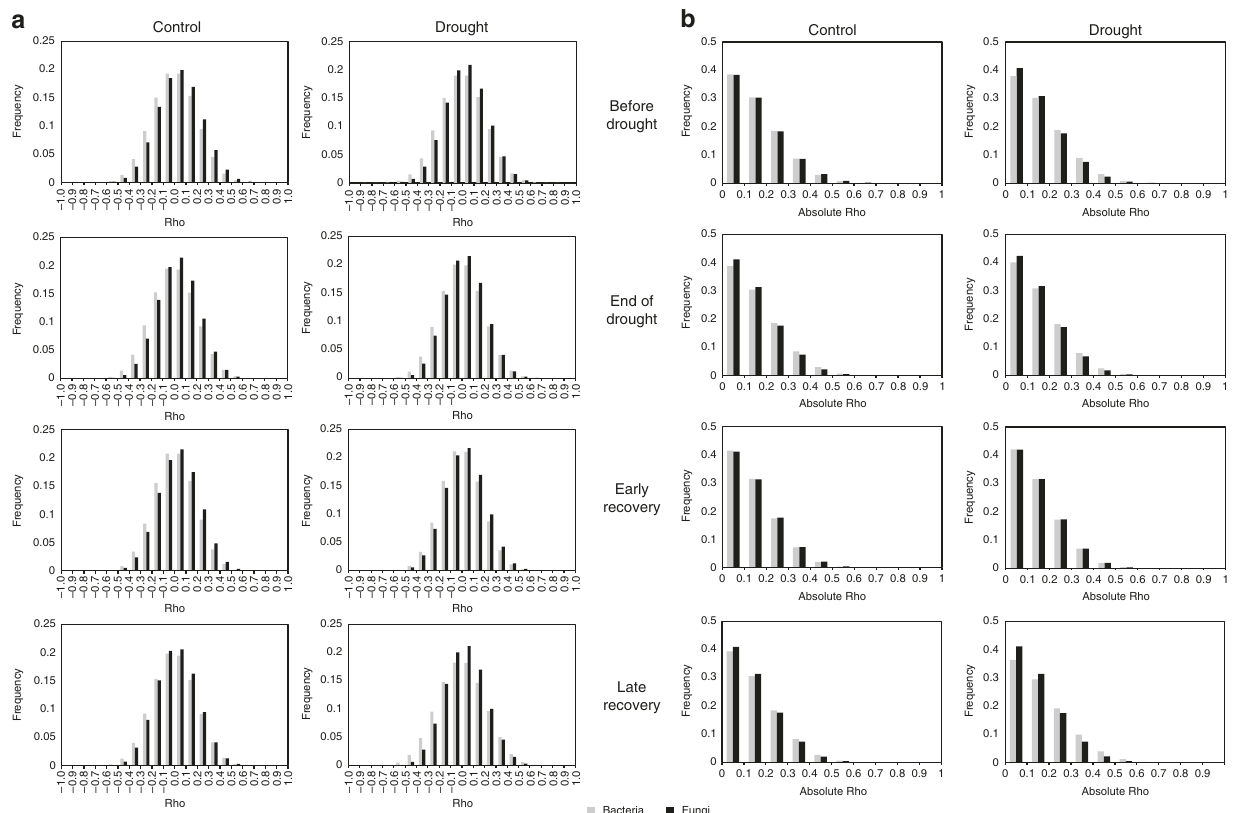
Fig. 3 Frequency distributions of correlations in fungal and bacterial networks. Frequency distributions of the sign and strength of all correlations in fungal and bacterial networks ( a ), and of the absolute strength of all correlations in fungal and bacterial networks ( b ), in drought and control treatments over time (top to bottom). Correlations in bacterial networks are light grey, correlations in fungal networks are dark